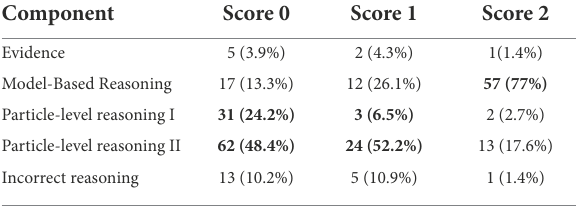
TABLE 6 Misscores by component of MA rubric for item